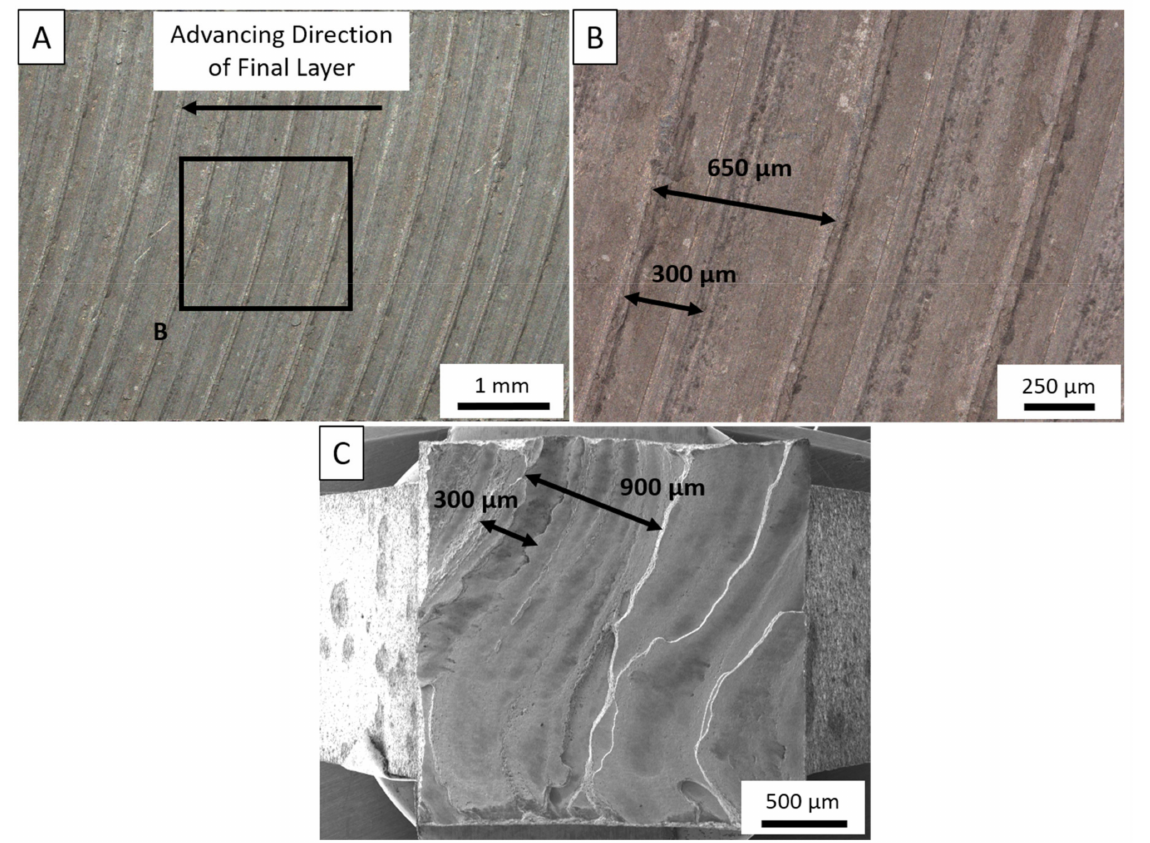
Figure 10. ( A ). Macroscopic image of the onion ring structure on the final layer of the deposit taken as observed directly below the tensile sample observed in ( C ). ( B ) High-magnification OM of the onion ring pattern depicting distances between rings. ( C ) SEM fractography correlating flow patterns with onion ring structures observed in OM.